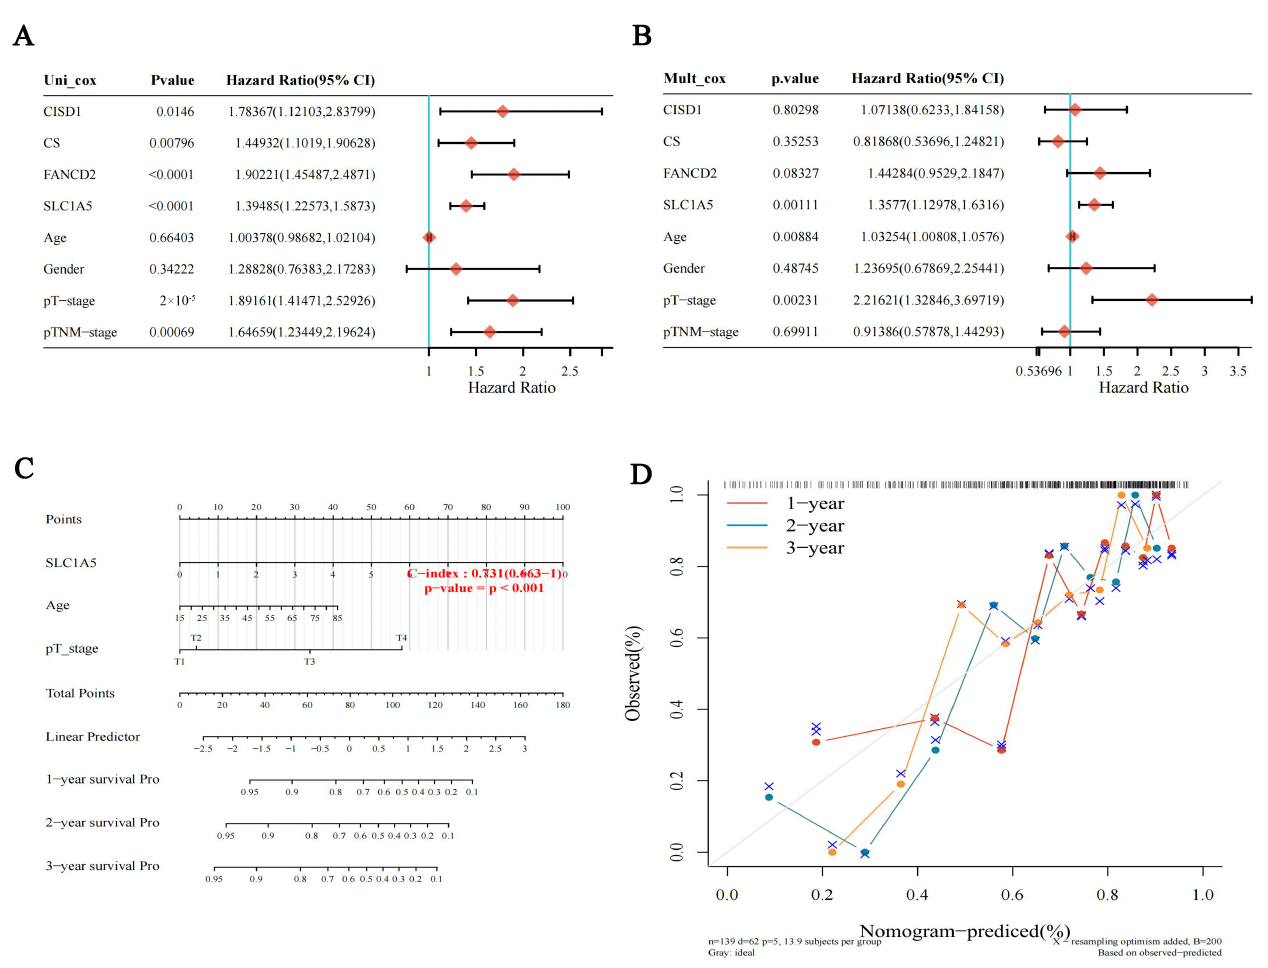
Figure 2. Overall survival analysis of FANCD2, CS, SLC1A5 and CISD1 in HBV ‐ related HCC. ( left ) Kaplan–Meier survival analysis of FANCD2 ( A ), CS ( B ), SLC1A5 ( C ) and CISD1 ( D ) signature from the TCGA dataset, comparison among different groups was made by log ‐ rank test. HR (High exp) represents the hazard ratio of the low ‐ expression sample relatives to the high ‐ expression sample. HR > 1 indicates the gene is a risk factor, and HR < 1 indicates the gene is a protective factor. HR(95%Cl), the median survival time (LT50) for different groups. ( right ) The ROC curve of the genes. Higher values of AUC correspond to higher predictive power.